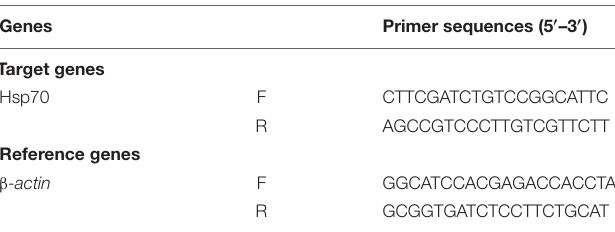
TABLE 1 | Primer sequences used in RT-PCR and candidate reference gene analyses in response to heat stress treatments. Genes Primer sequences (5 (cid:48) –3 (cid:48)